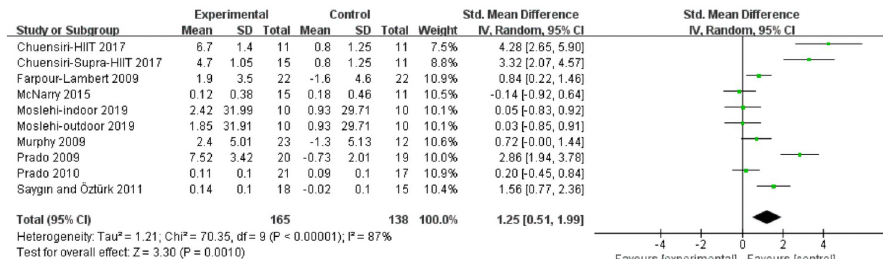
Fig 9. Forest plot of comparison: VO 2